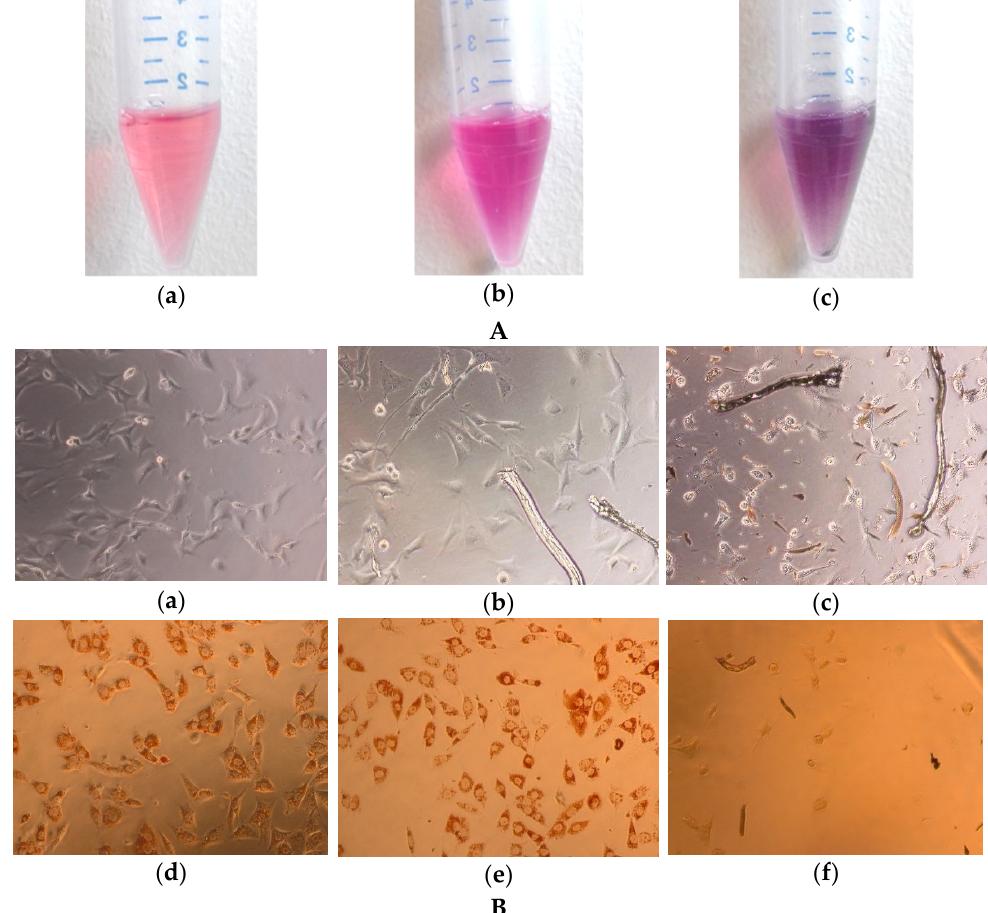
Figure 9. ( A ). Images showing exposure medium treated in the same way as (NC) extracts ( a ), unmodified cotton extract ( b ), and modified cotton extract ( c ), ( B ). Light microscopy images of BALB/3T3 clone A31 cells exposed for 24 h to negative control ( a , d ), 100% unmodified cotton extract ( b , e ), and 100% extract from COT–Zn sample ( c , f ), before and after incubation with NR, respectively.